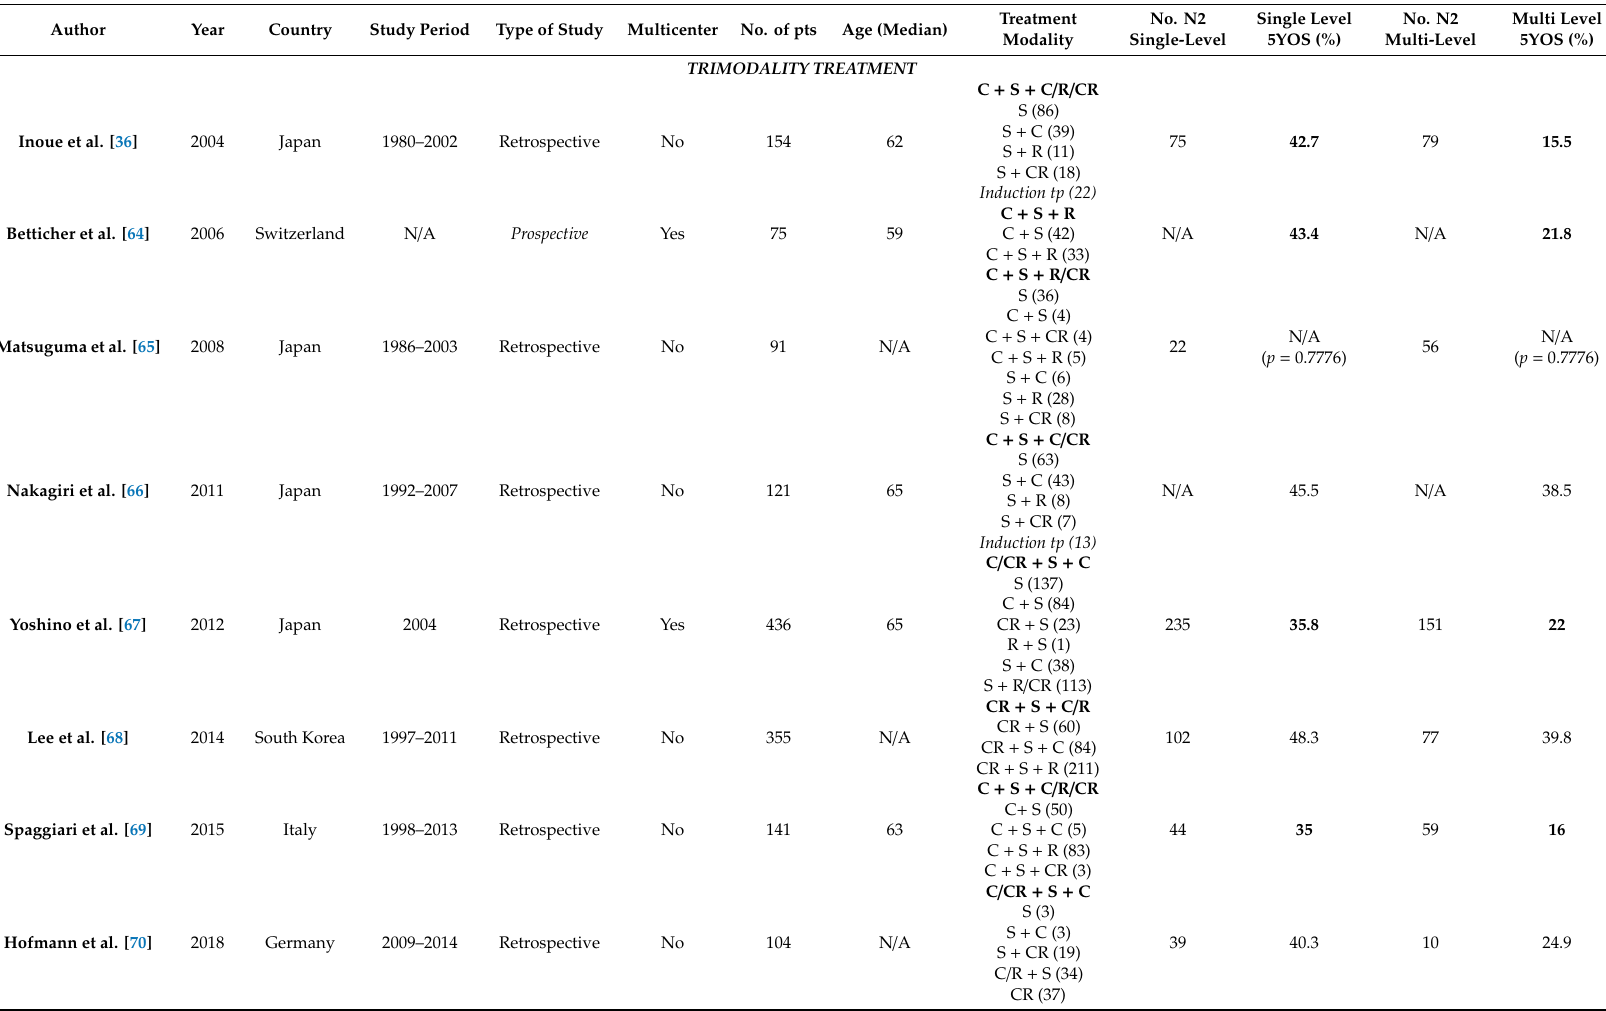
Table 1. Studies comparing overall survival (OS) in IIIA-pN2 patients with either single or multi-station metastases treated with multimodality treatment over the last 20 years. Di ff erence of values in bold is statistically